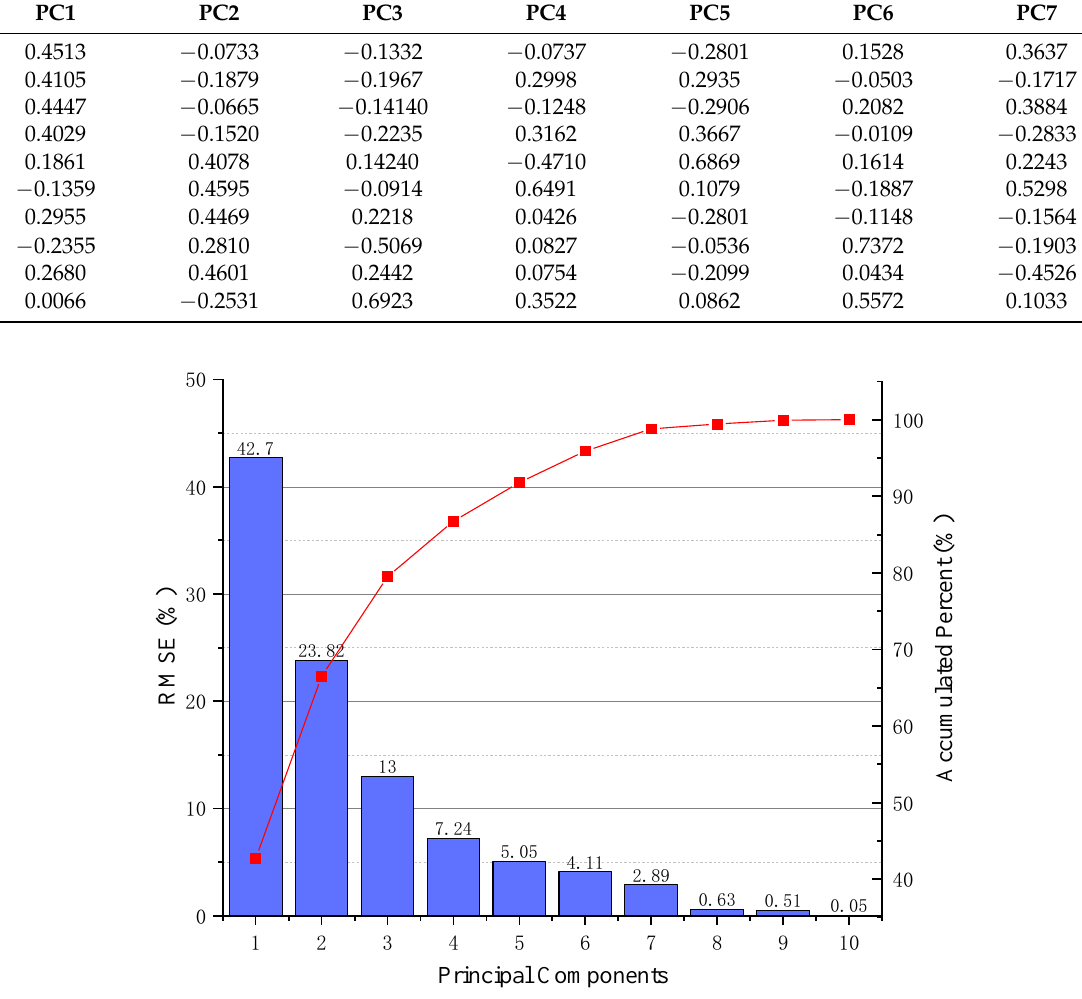
Figure 2. Significance of principal components.